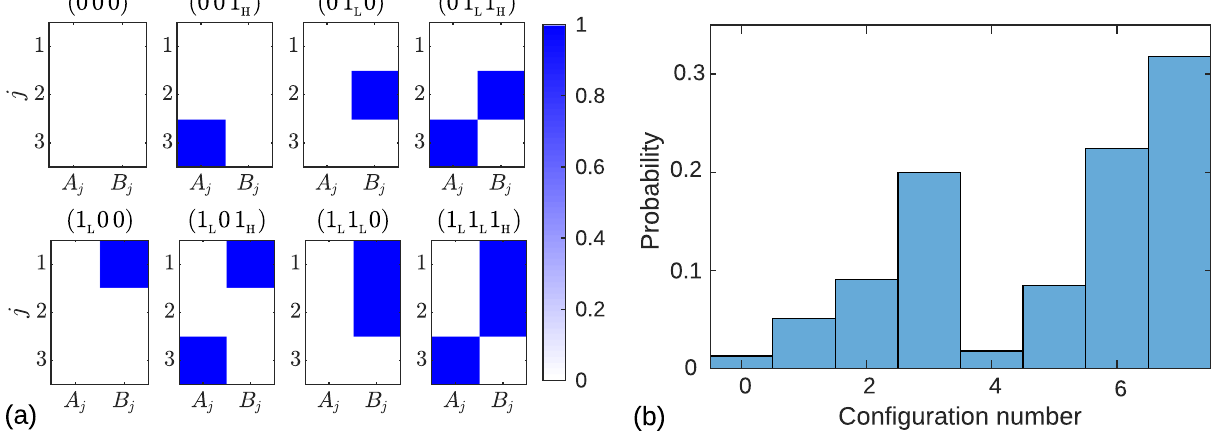
Figure 6. Results of three leaf star modeling. ( a ) Distributions of color-coded asymptotic values of coupling weights A j and B j for a three-leaf star network, obtained by integrating Eqs. (3) and (6) with different initial 0.85 conditions. The leaves natural frequencies are (ω 1 , ω 2 , ω 3 ) = (0.55, 0.7, 1). The hub natural frequency ω 0 = satisfies the inequality ω 2 < ω 0 < ω 3 . The resulting distributions are labeled with codes that agree with the theoretically predicted asymptotic configurations shown in the third column of Table 1. ( b ) Probability distribution of eight different asymptotic configurations for a three-leaf star network, when the hub frequency is in the interval between the frequencies of the second and third leaves, ω 2 < ω 0 < ω 3 . In panel ( a ), the configurations are numbered according to the decimal representation of the binary codes shown above each pattern in panel ( a ) (see main text for details). The distribution is constructed using 1000 randomly selected initial conditions for Eqs. (3) and (6). The initial values of the weights A j and B j were randomly and 0, α independently taken from the uniform distribution [ ] 1 , when the hub frequency is greater than the highest frequency of the leaves, ω N < ω 0 . Summarizing k N = + ( k ) the results of sections dedicated to two and three leaf networks, we found that the code C n of the n th asymp- totic configuration for any N can be written as follows. First, we represent the decimal number n in binary: ( d N n 1 d N 2 . . . d 0 ) 2 = = − − (cid:31)